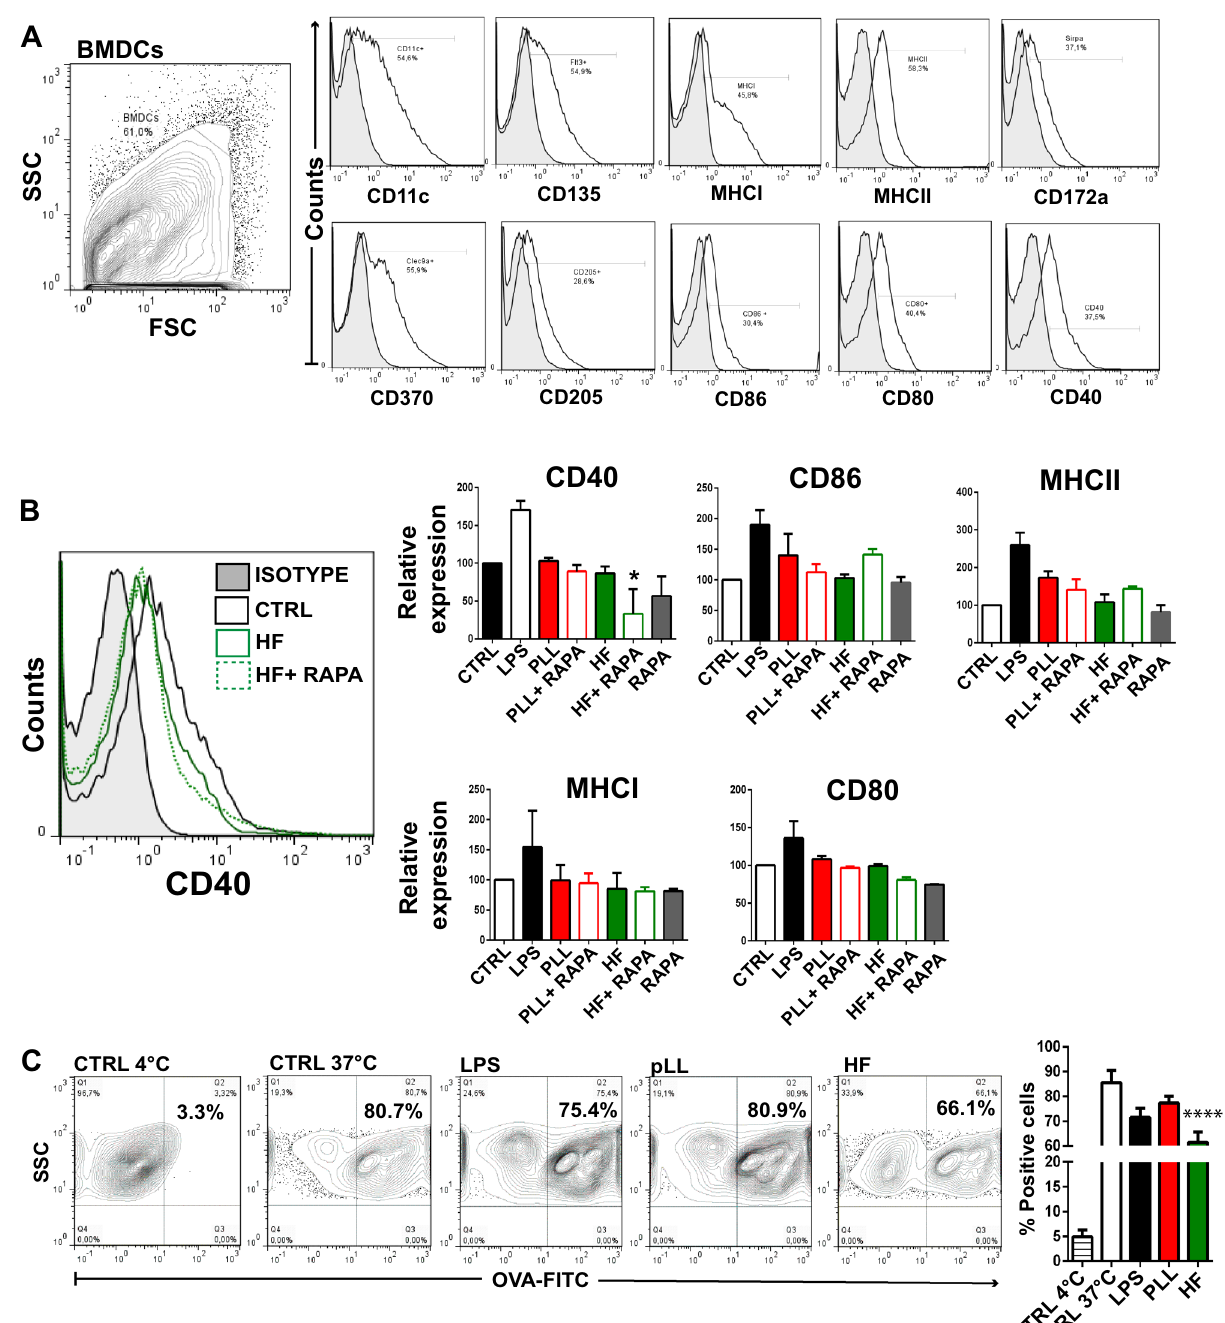
Figure 2. Purified laminar layer and hydatid fluid induce a slight maturation phenotype on BMDCs. BMDCs (1 × 10 6 /ml) were cultured alone (CTRL), with 20 μg pLL or 5 μg HF for 18 h. Then, BMDCs were harvested and their phenotype was analyzed